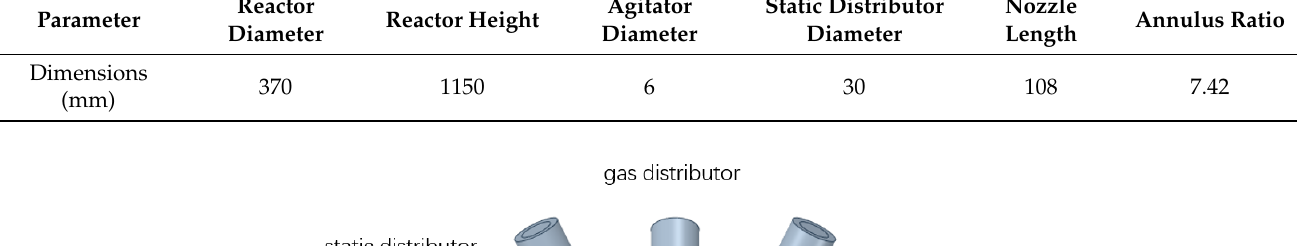
Figure 6. Schematic diagram of gas distributor.